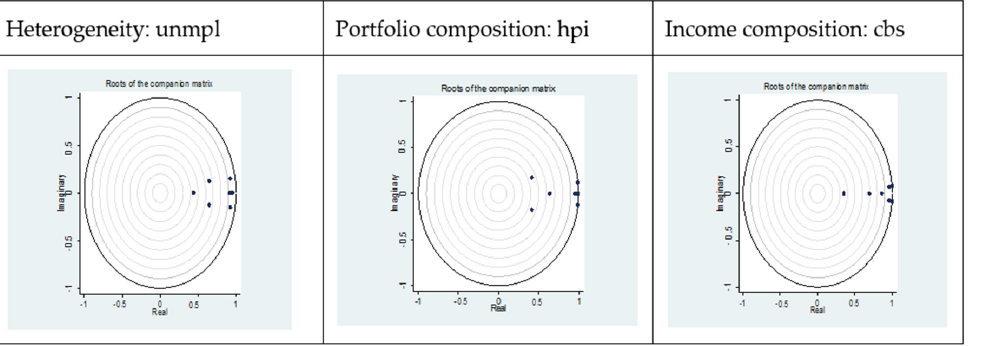
Figure A2. Response of inequality on unconventional monetary policy (heterogeneity channel). Note: The shaded areas refer to the 95% confidence band. Moreover, the IRFs present two periods, which are a short run from zero to four years and a long run from five to 10 years. Therefore, the orthogonalised IRF is interpreted aligned with the short-run and long-run periods as defined. Source : Author’s illustration based on SWIID (Solt 2020; World Development Indicators 2022).